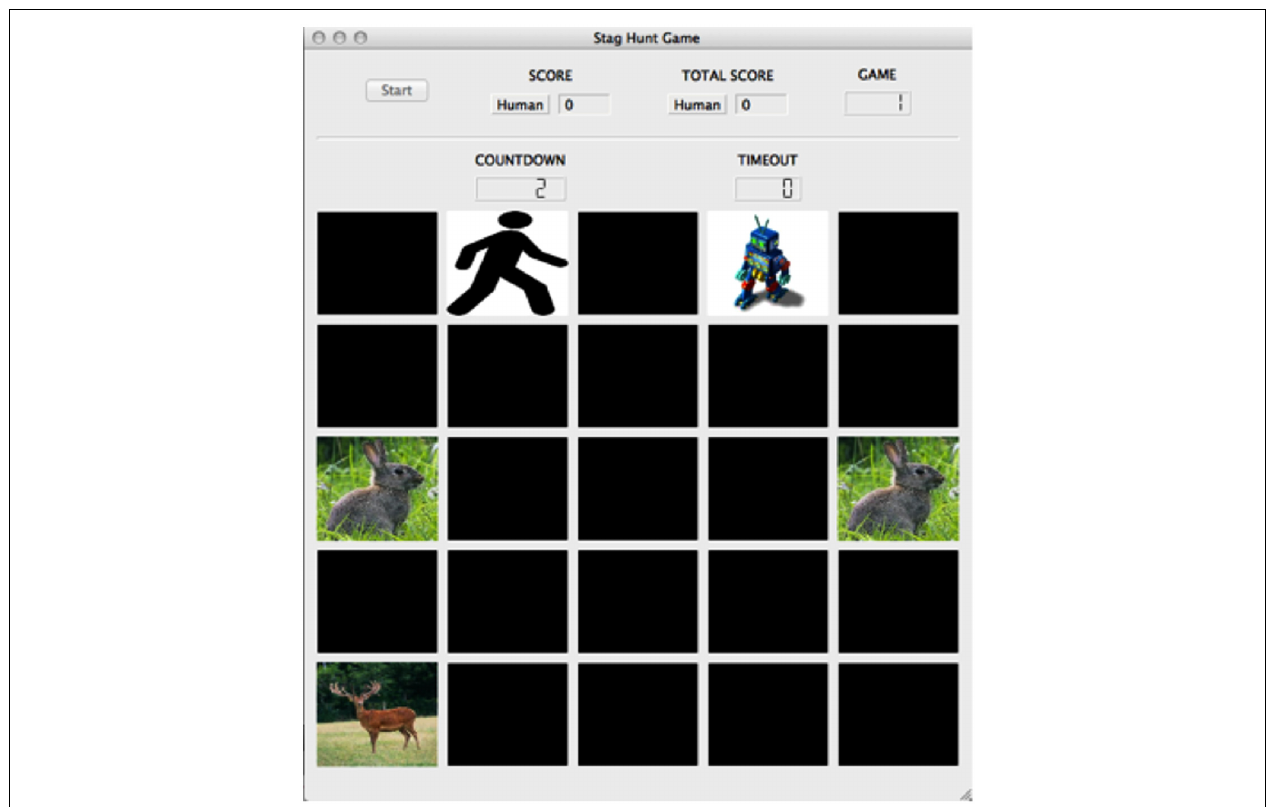
number, a countdown to the start of the game, and a counter monitoring the game’s timeout. In the game of Stag Hunt, two players attempt to hunt a low-payoff hare alone, or attempt to cooperate with the other player to hunt a large payoff stag. © 2013 by Adaptive Behavior. Reprinted by Permission of SAGE from Craig etal.